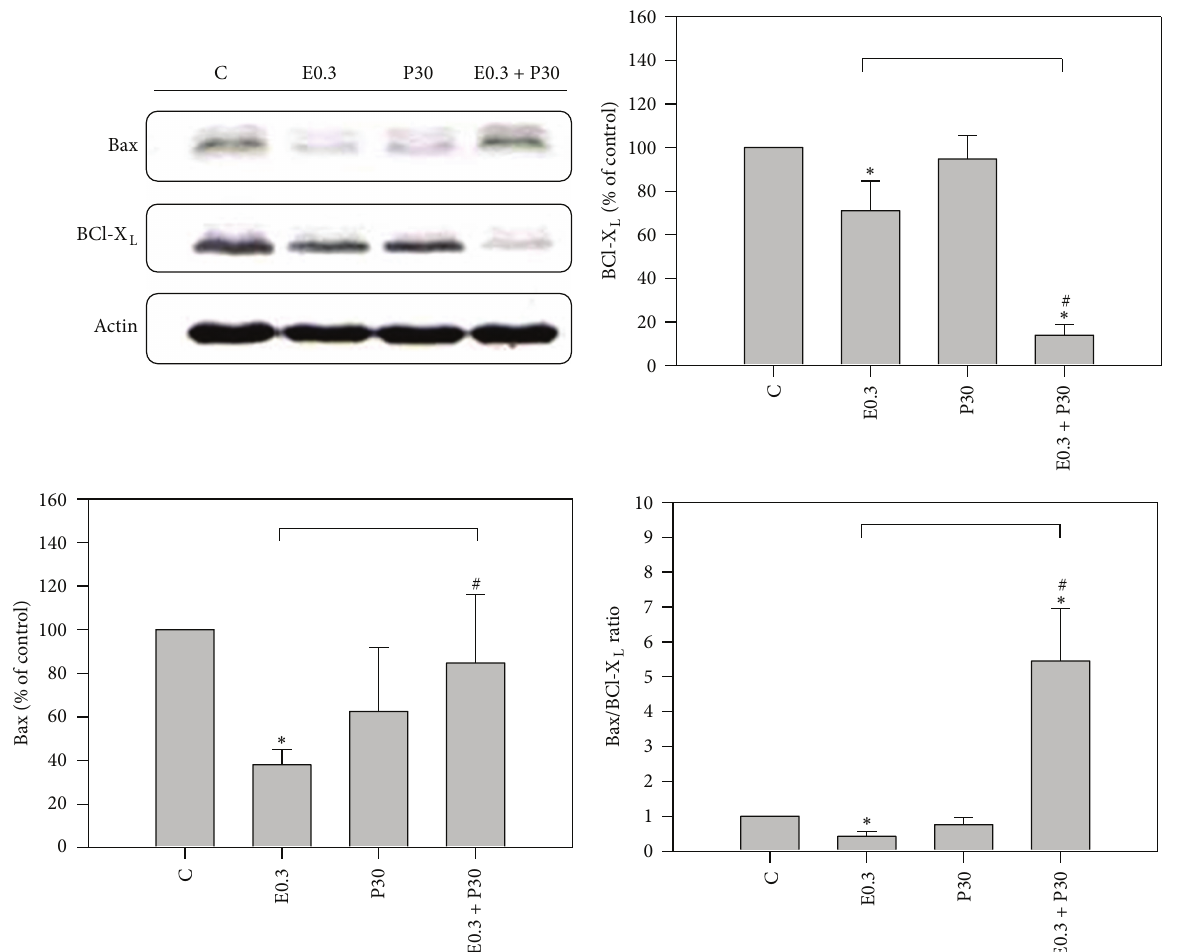
Figure 3: Western blotting shows Bax and Bcl-X L expressions of HA22T/VGH cells after epirubicin and/or progesterone treatment for 24 h. Results are expressed as the mean ± standard deviation (S.D.) for three separate experiments. C: untreated cells, E0.3: 0.3 𝜇 M epirubicin, and P30: 30 𝜇 M progesterone. ∗ 𝑃 < 0.05 compared to the untreated controls. # 𝑃 < 0.05 compared to epirubicin-treated